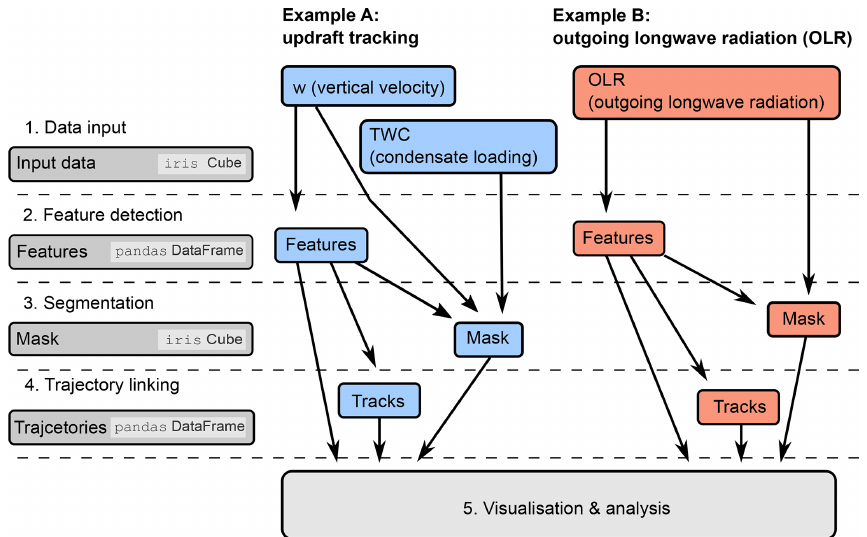
Figure 1. Schematic overview of the general workflow of the tobac tracking analysis framework and of the two examples presented in this